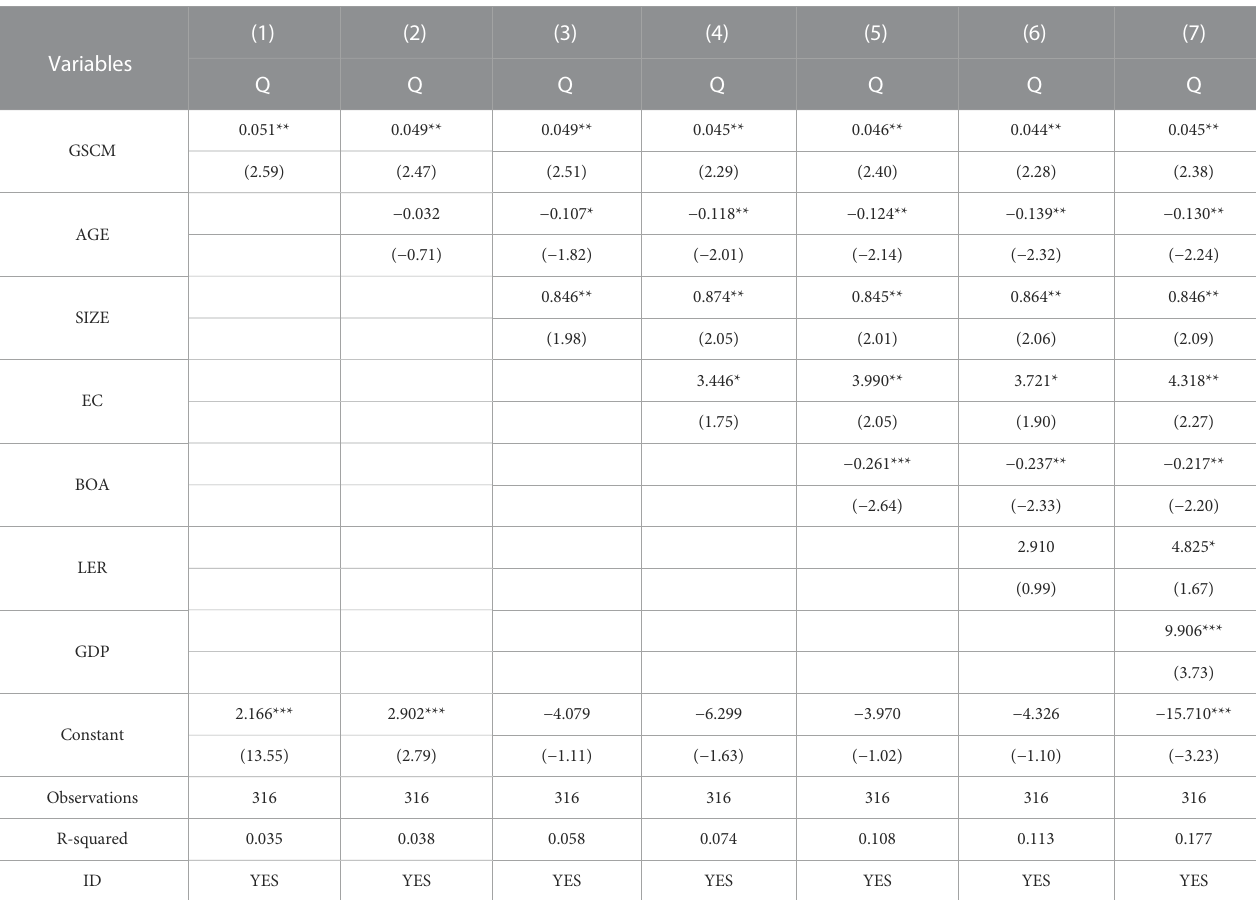
TABLE 2 Stepwise